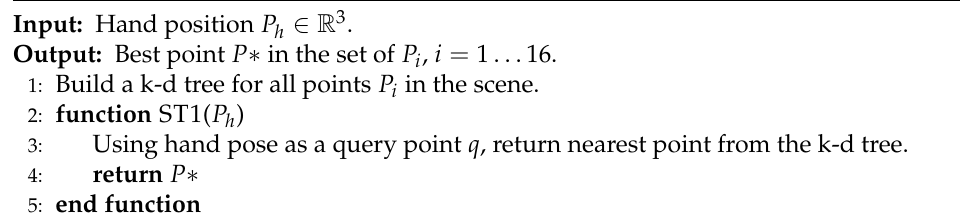
Figure 3. Pictorial representation of strategy 1. Algorithm 1 Strategy 1: Predictions with hand.